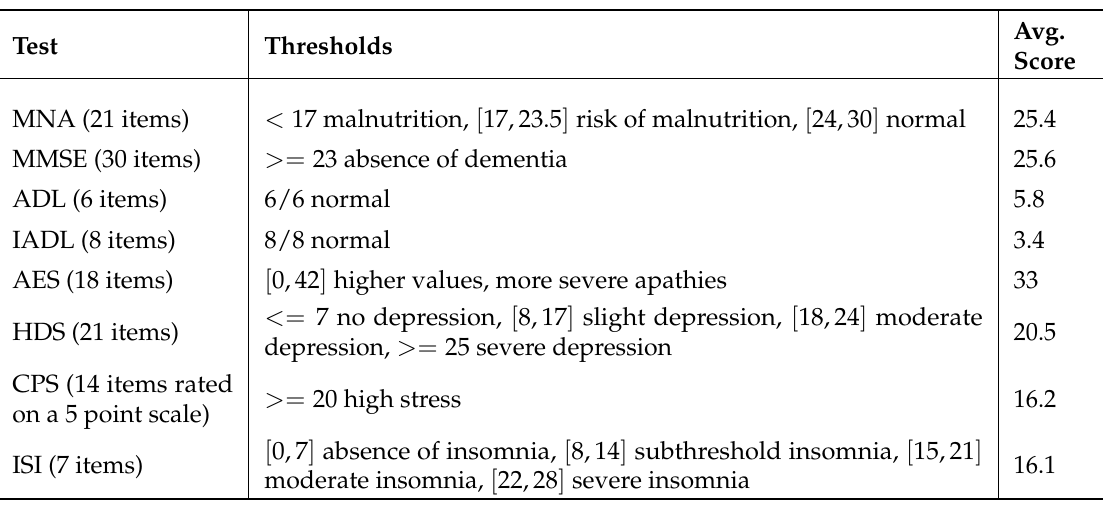
Table 1. Voluntary screening and